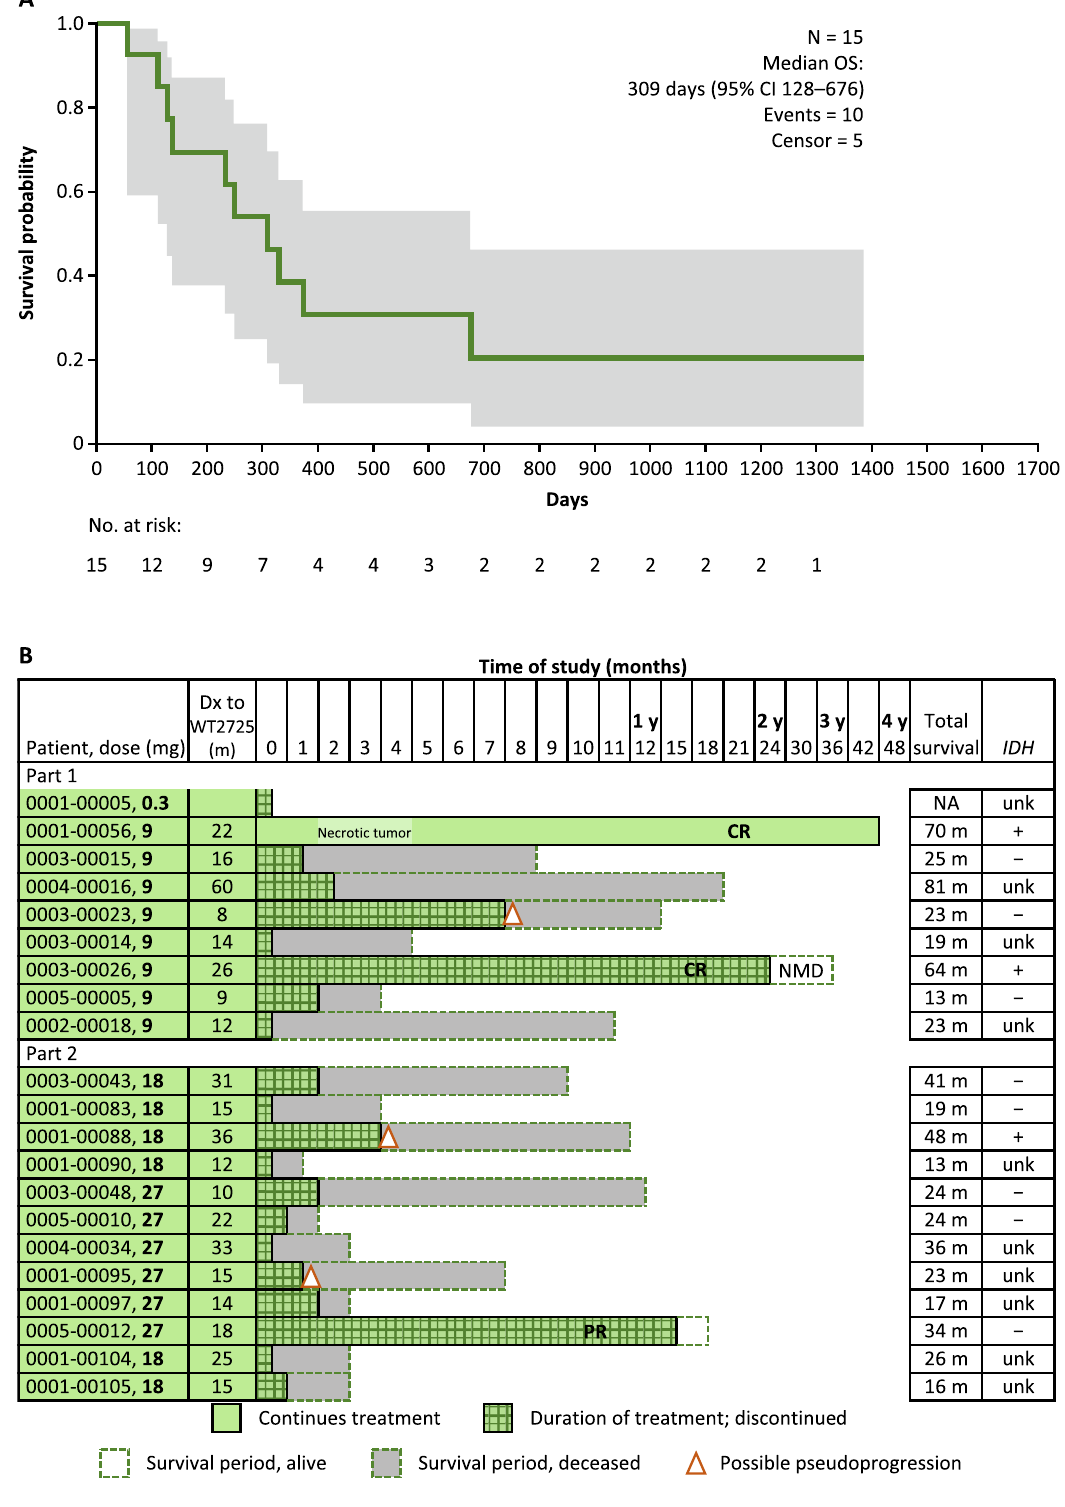
Figure 2. Patient survival in the glioblastoma subgroup. ( A ) OS. The shaded area represents the 95% CI of the survival probability at that day. ( b ) Individual patient survival. CI confidence interval, CR complete response, Dx diagnosis, IDH isocitrate dehydrogenase, m months, NMD no measurable disease, OS overall survival, PR partial response, unk unknown, y